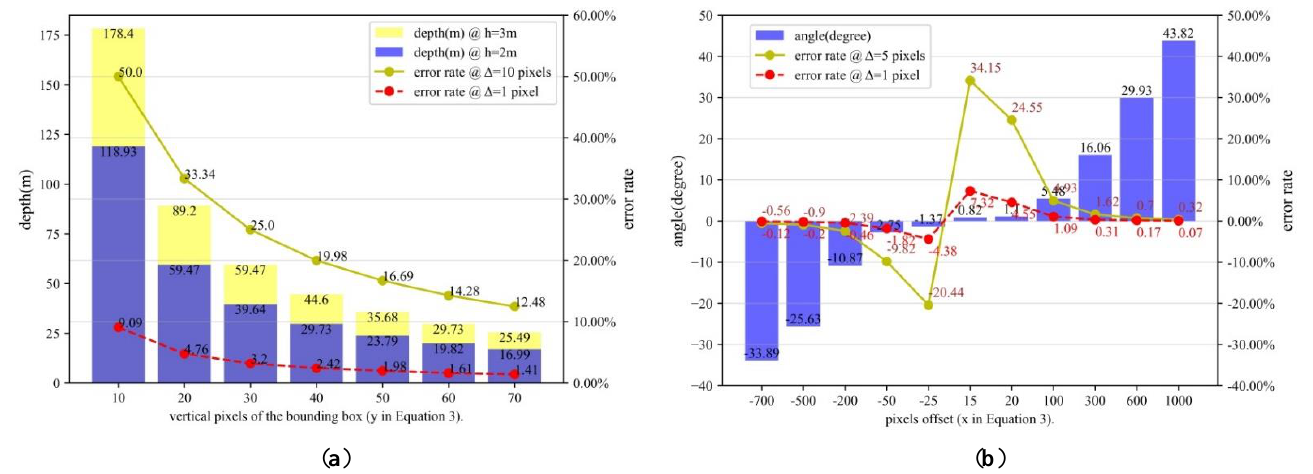
Figure 4. PRS simulations along with imaging system parameters of KITTI dataset. Assuming that x and y are accurate. ( a ) The depth results at different h and error rate if the vertical pixels of bounding box is y + Δ . ( b ) The angle results and error rate if the pixels offset is x + Δ .